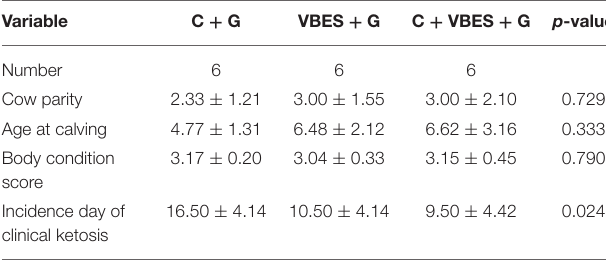
TABLE 2 | Descriptive statistics for dairy cows by each treatment included in the study.